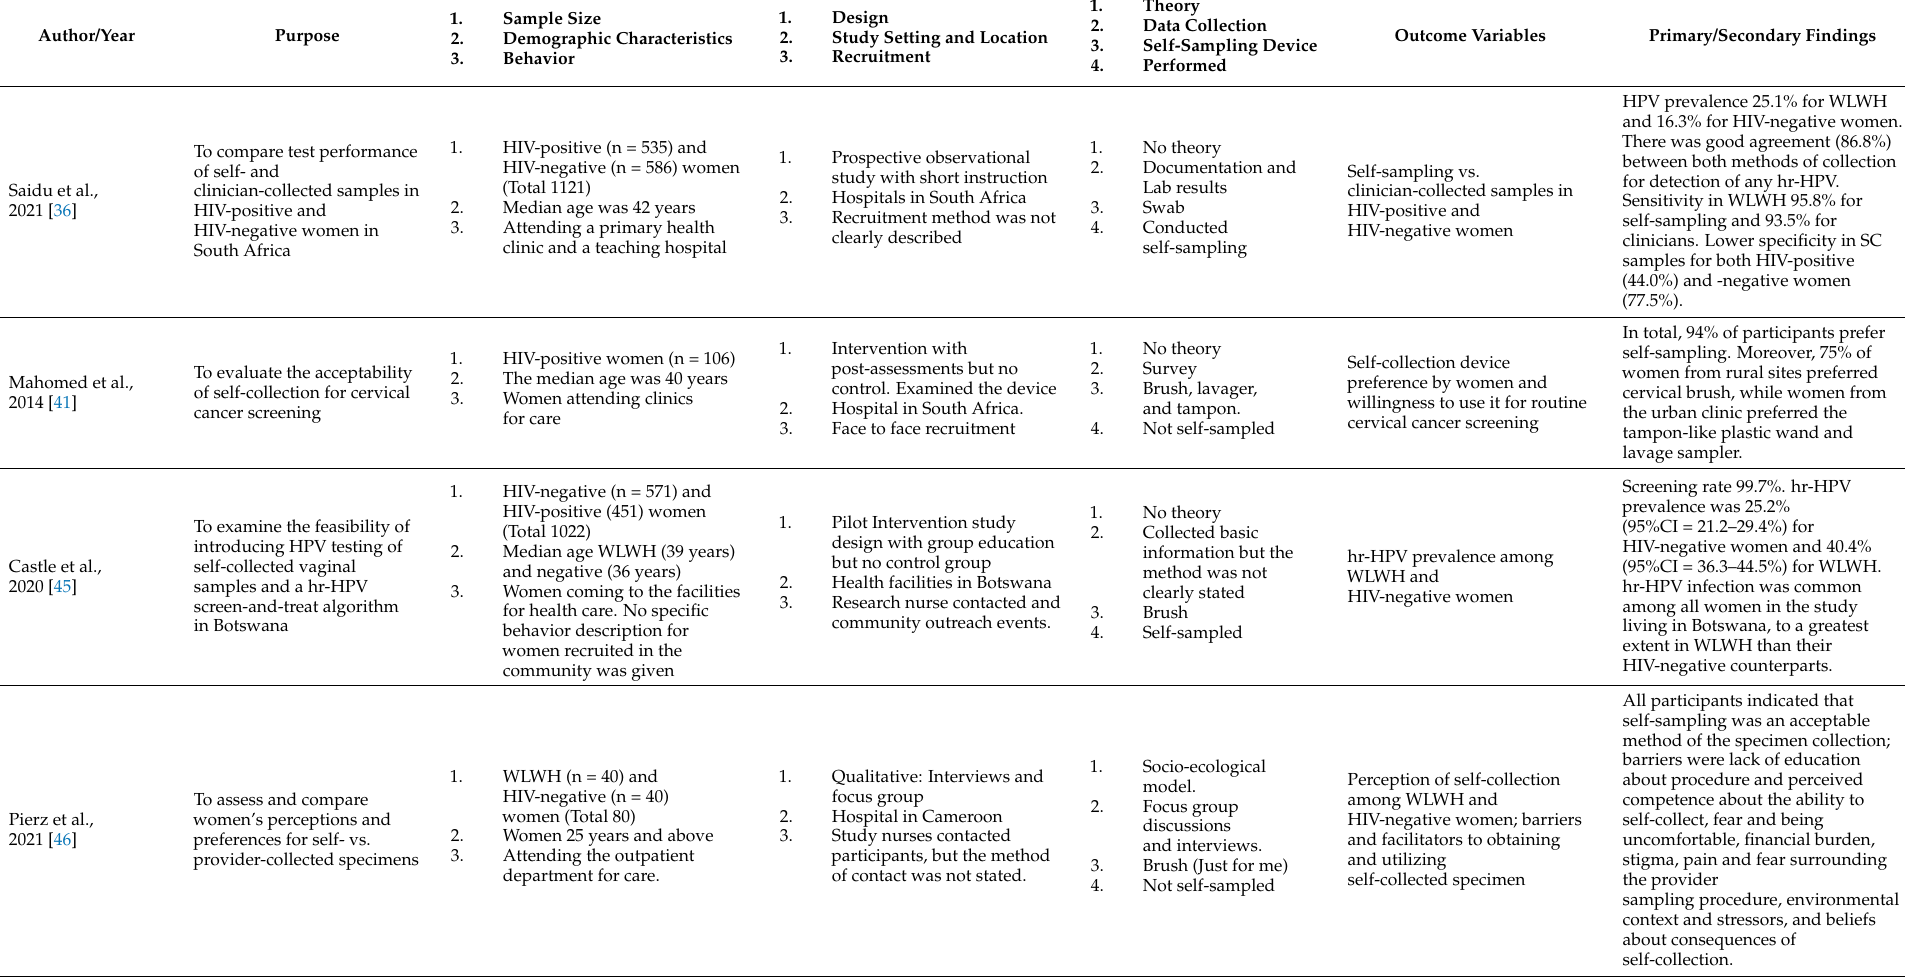
Table 1. Summary of self-sampling among women living with HIV in low- and middle-income